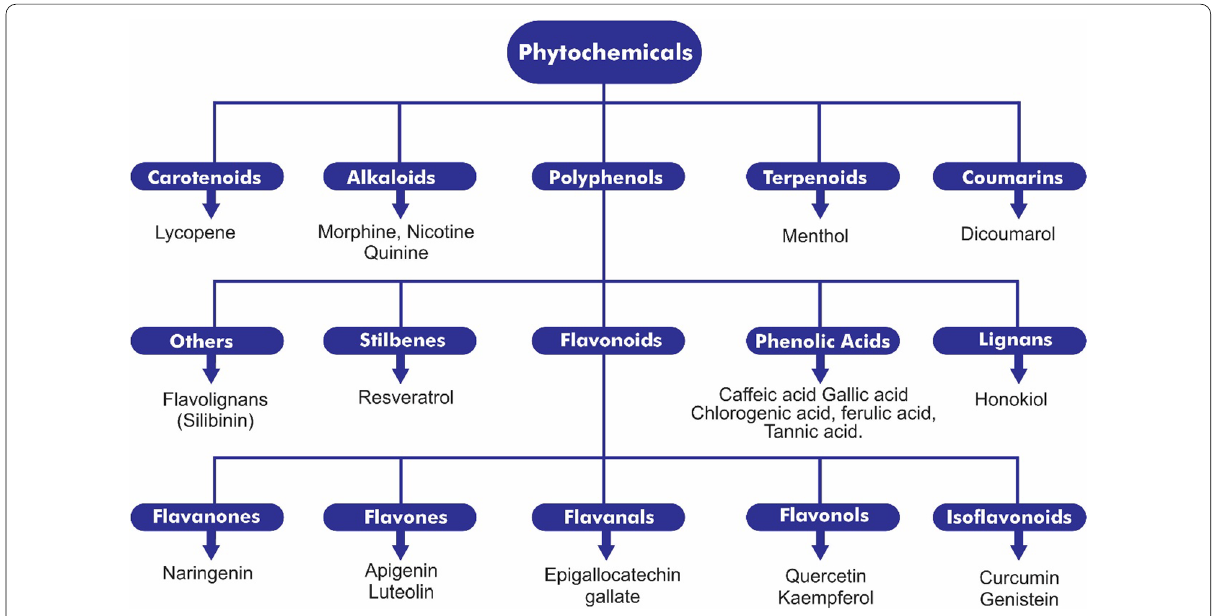
Fig. 2 Classification of